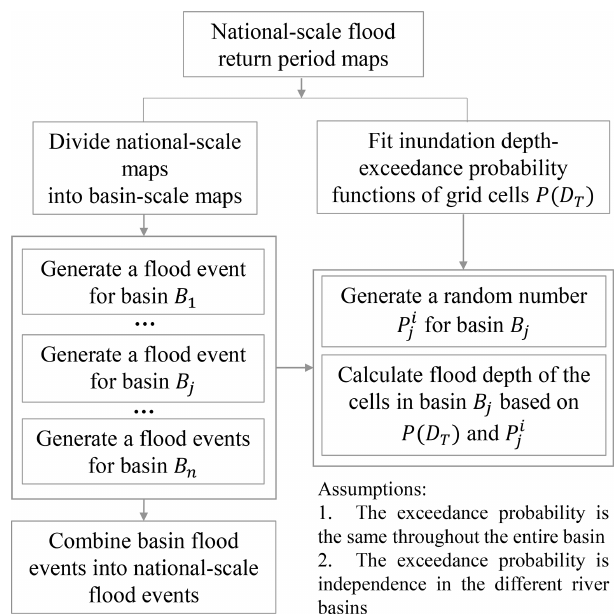
Figure A2. A flowchart to generate flood events.